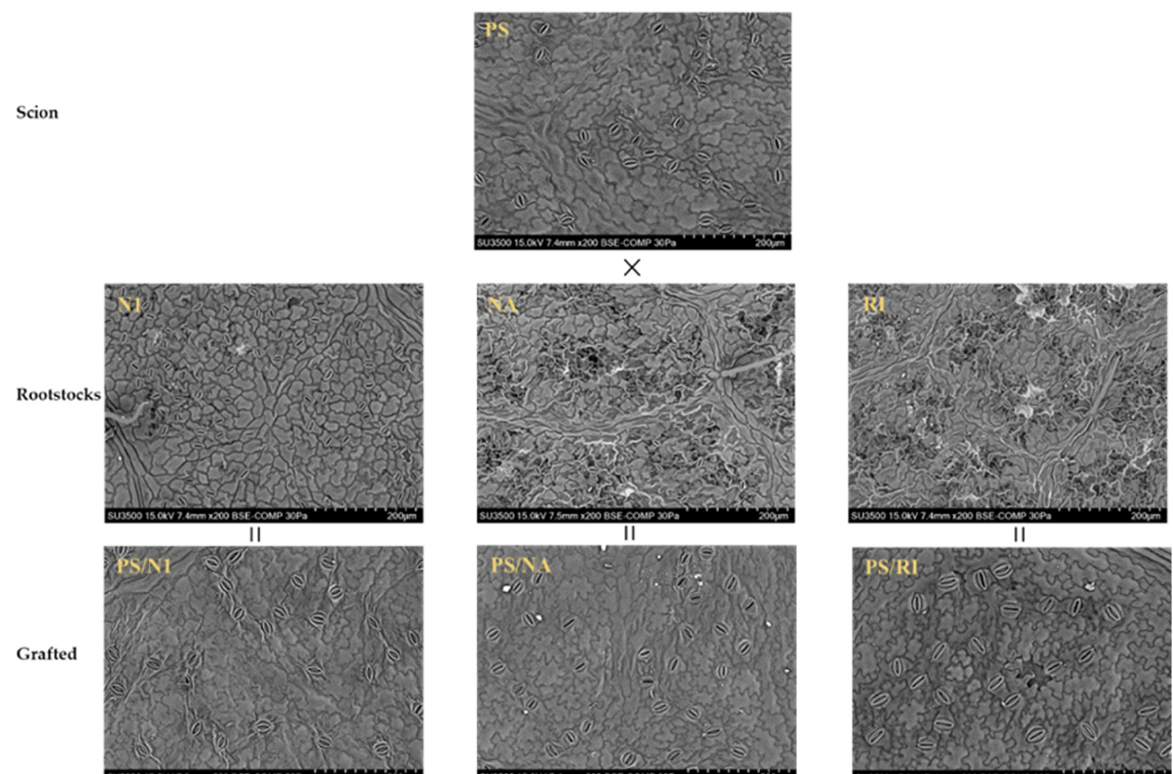
Figure 2. The guard cells and stomatal size of one scion, three rootstocks, and three grafted cut rose flowers taken with scanning electron microscopy. PS: scion plant of spray rose Rosa hybrida cv. Pink Shine; N1: rootstock of Rosa multiflora cv. Hort No. 1; NA: rootstock of Rosa canina cv. Natal Briar; RI: rootstock of Rosa indica cv. Major; PS/N1: PS grafted onto N1; PS/NA: PS grafted onto NA; PS/RI: PS grafted onto RI.3.3. OJIP and photosynthesis of cut rose